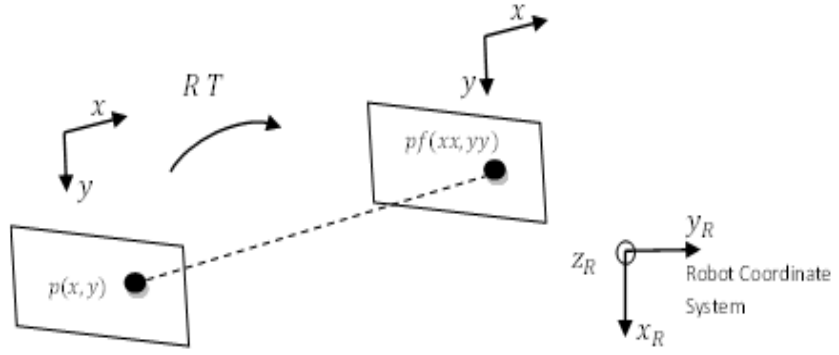
Figure 3. Image and Cartesian Coordinate System.